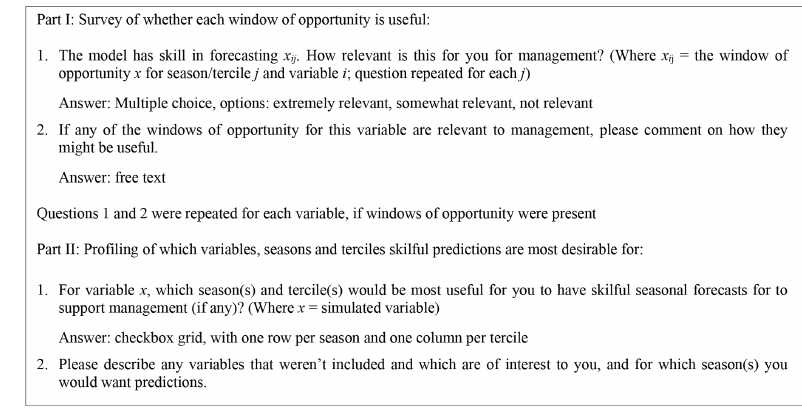
Figure A1. Questions posed to water managers to assess the usefulness of the windows of opportunity.